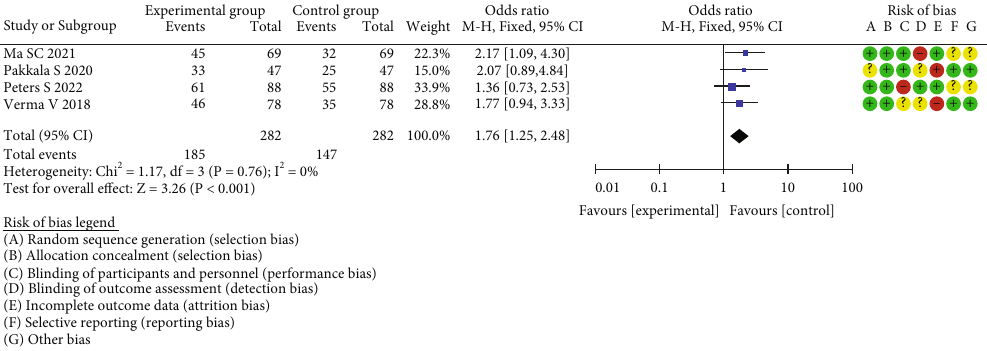
Figure 5: Meta-analysis of adverse reactions of adoptive immunotherapy in experimental group and control group in non-small-cell lung cancer.